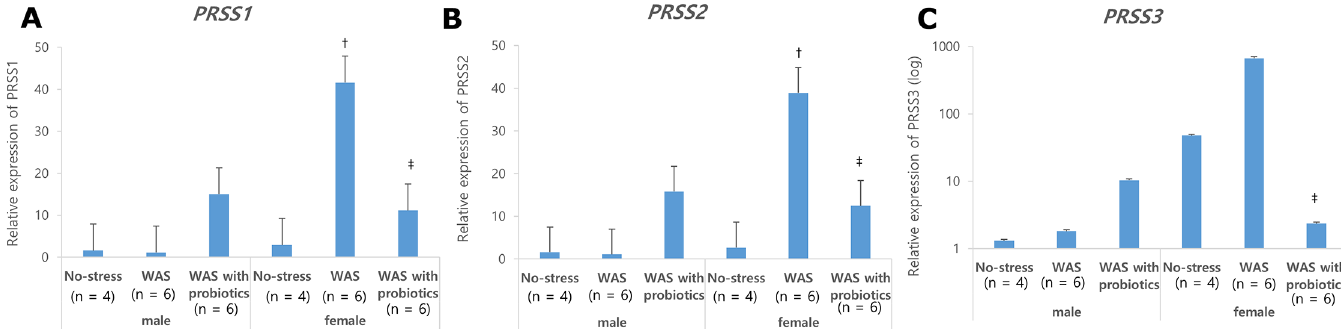
Fig 6. The qPCR expression of PRSS1 , PRSS2 and PRSS3 . 2 (A) The expressionof PRSS1 was significantly higher in female water avoidancestress (WAS) group than those in male WAS group. The treatment of probiotics significantly decreased WAS-inducedhigherexpressionof PRSS1 in female. However, there was no significantchangein male. (B) The expressionof PRSS2 was also similar to PRSS1 infemale group. (C) In case of PRSS3 the treatment of probiotics significantly decreasedWAS-induced higherexpressionof PRSS1 in female but there was no significantdifference betweencontrol group and WAS group in both of female and male. * P < 0.05 comparedwith no-stress and WAS group in male; † P < 0.05 compared with female no-stress group; ‡ P < 0.05 comparedwith female WAS group.